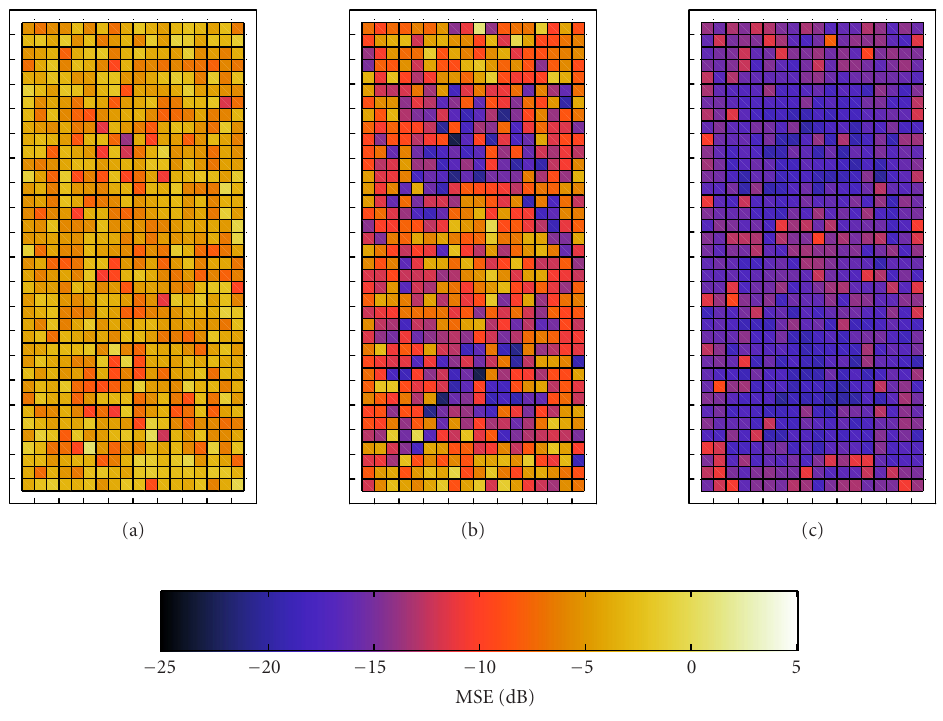
Figure 8: Average MSE of 32 subcarriers, averaged over 500 OFDM symbols, with 4-QAM modulation. (a) 1 element M = 6. (b) Fixed beamformer M = 6. (c) Adaptive beamformer M =